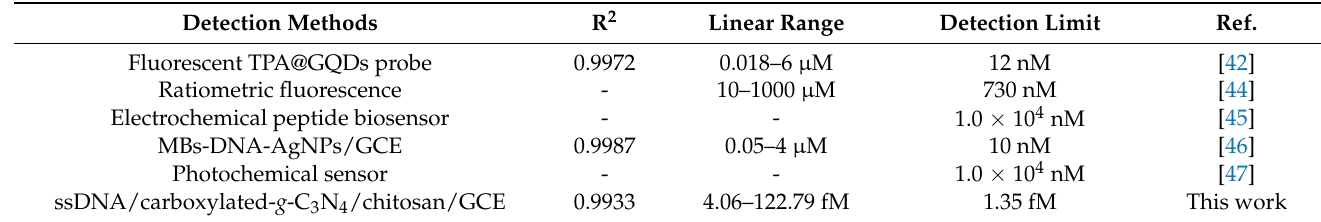
Table 1. Comparison of analytical performance of different methods for detection of • OH.